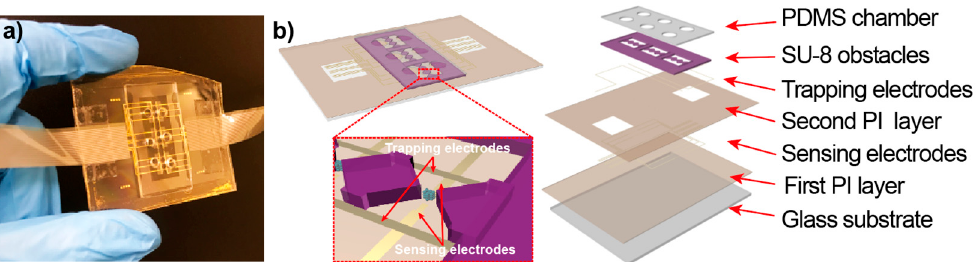
Figure 1. ( a ) The picture of the Lab-on-a-Chip (LOC) device. ( b ) Schematic of the LOC device including the insulator-based dielectrophoresis (iDEP) module for particle trapping (polydimethylsiloxane (PDMS) chamber, SU-8 obstacles, and Trapping electrodes) and the impedance sensing module (Sensing electrodes).